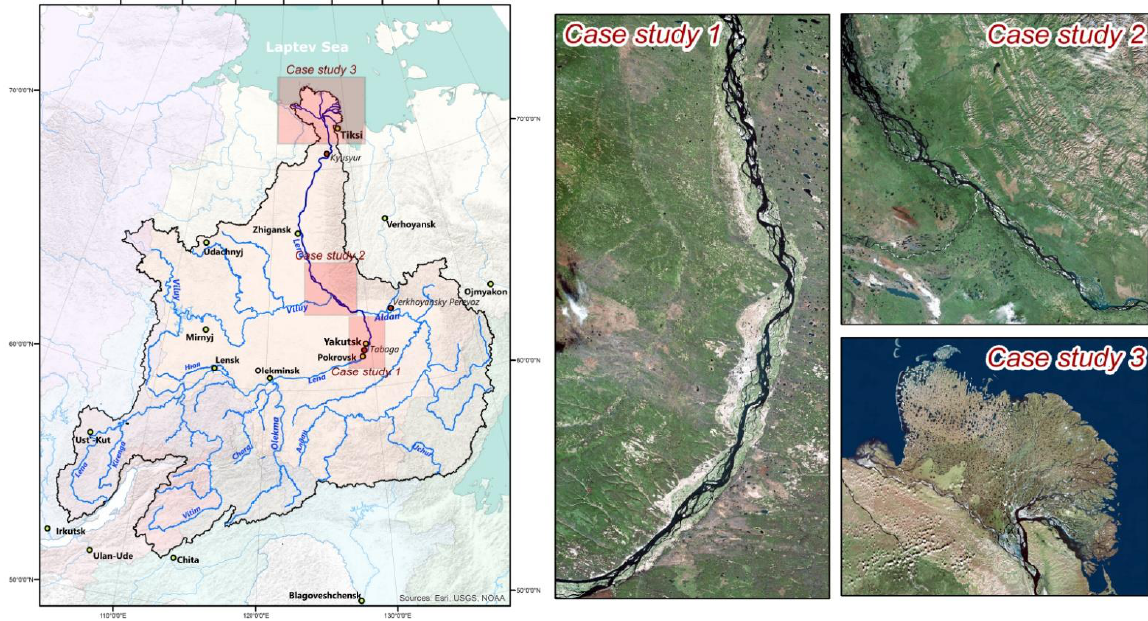
Figure 1. Lena River basin and the locations of case